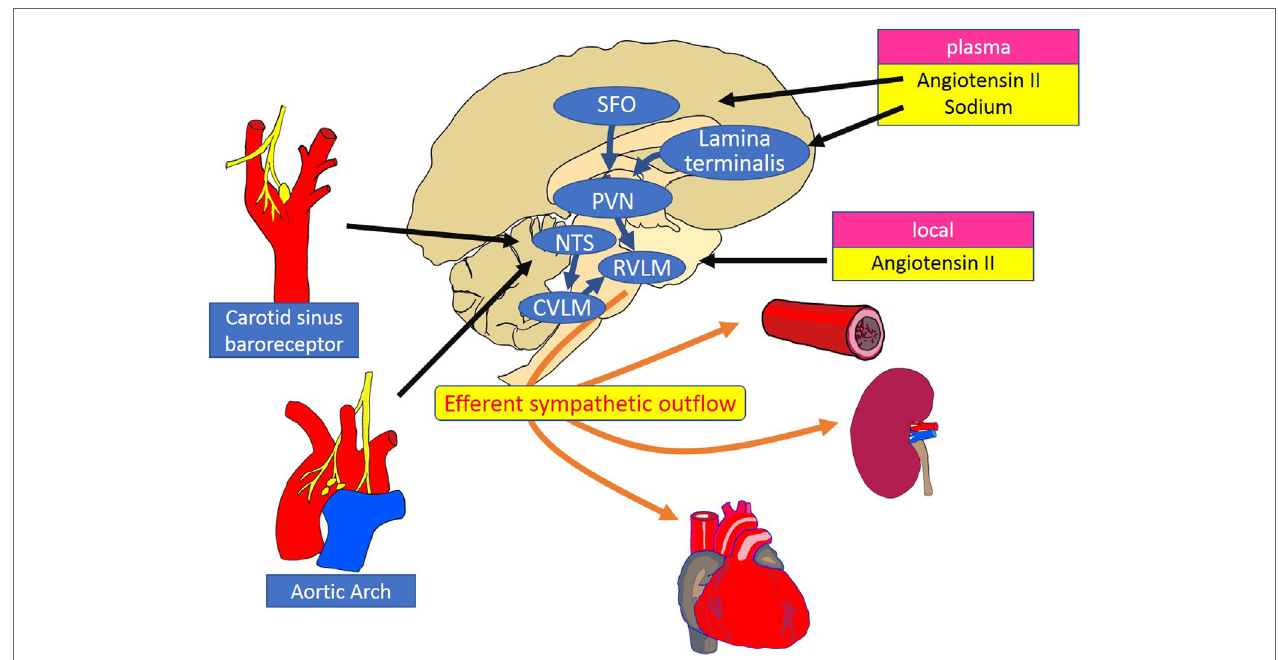
FigURe 2 | Schematic diagram of the central and peripheral mechanisms of sympathetic regulation of the heart, vessels, and kidneys. The RVLM plays a key role as a cardiovascular centre that receives and integrates peripheral signals providing information on blood pressure, fluid volume, and oxygen saturation. Instant changes in blood pressure are perceived by baroreceptors and transferred to the NTS as an input signal of baroreflex control of sympathetic outflow. Stimulation of the SFO by circulating angiotensin II increases the efferent sympathetic activity through the activation of the PVN and the RVLM neurons. Inhibitory pathways are activated between the lamina terminalis and PVN in response to plasma sodium. Increased activity of the RVLM neurons is transmitted to the intermediolateral cell column of the spinal cord, where peripheral sympathetic nerves to the heart, arteries and kidneys are activated. RVLM, rostral ventrolateral medulla; NTS, nucleus tractus solitarius; CVLM, caudal ventrolateral medulla; PVN, paraventricular nucleus; SFO, subfornical